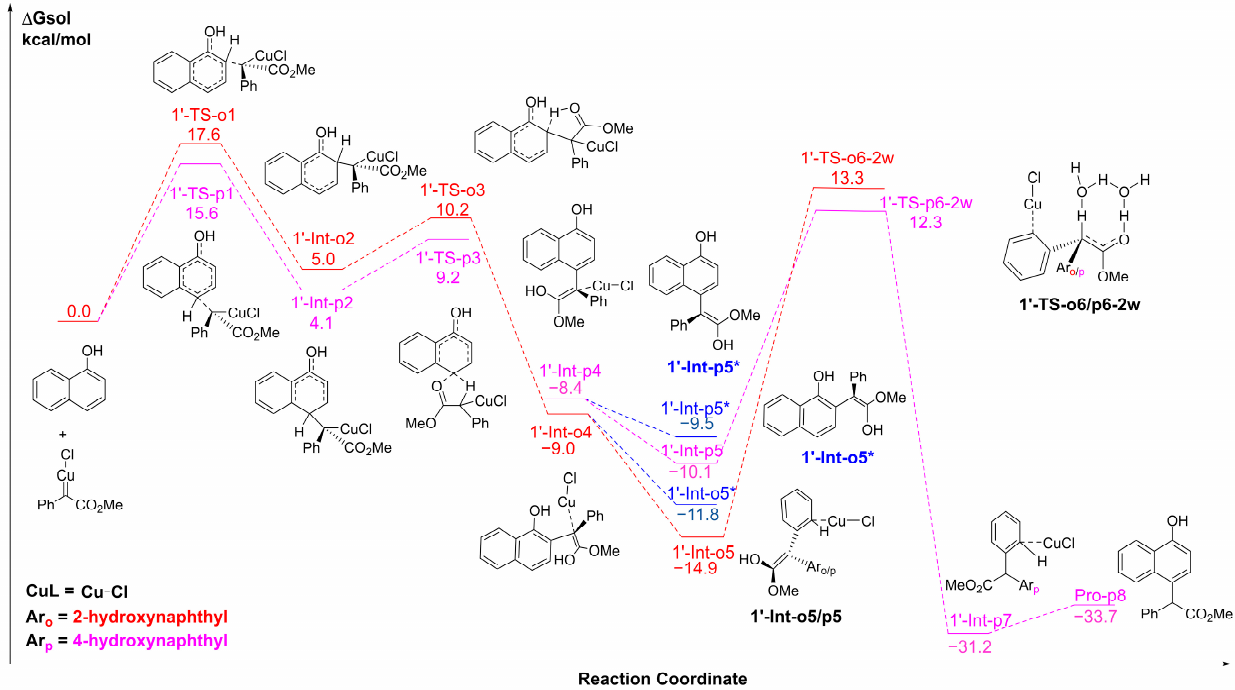
Figure 4. The calculated free energy profiles Δ G sol and the corresponding structures of intermediates and transition states along different pathways of the C–H bonds of naphthols inserted by the monometallic carbenes of the CuCl monomer. The reasonable ortho-selective pathway is shown in red, the para-selective pathway is pink, and other possible pathways are in blue. The free energies are given in kcal mol − 1